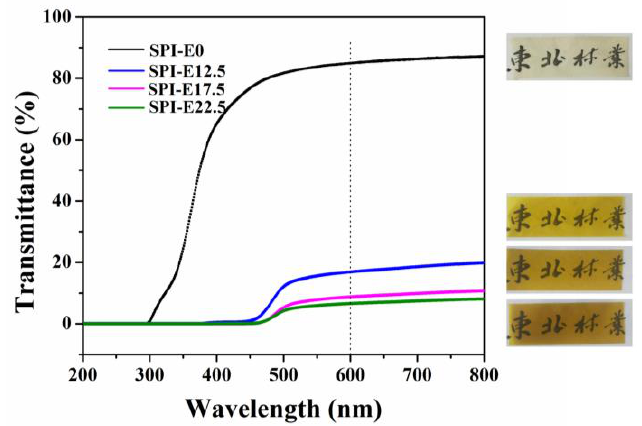
Figure 6. Light transmission of the SPI-based